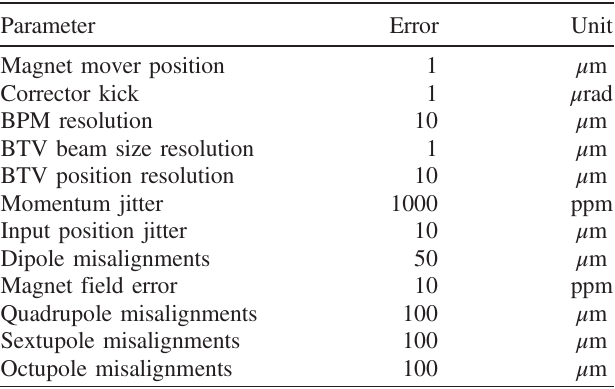
TABLE IV. The rms values for the distributions of errors and resolutions used for simulations of the Run 2c witness transfer